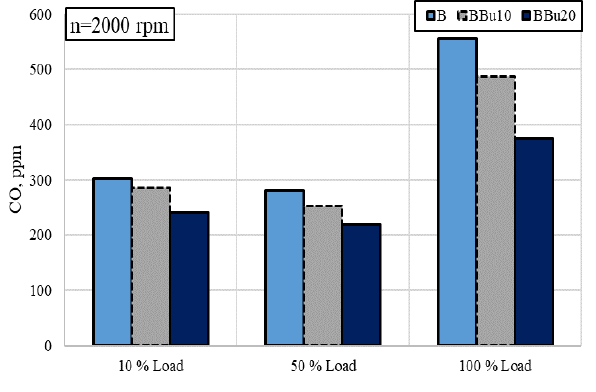
Fig. 5. Dependencies of carbon monoxide (CO) emissions on engine load when running at maximum torque speed of 2000 rpm